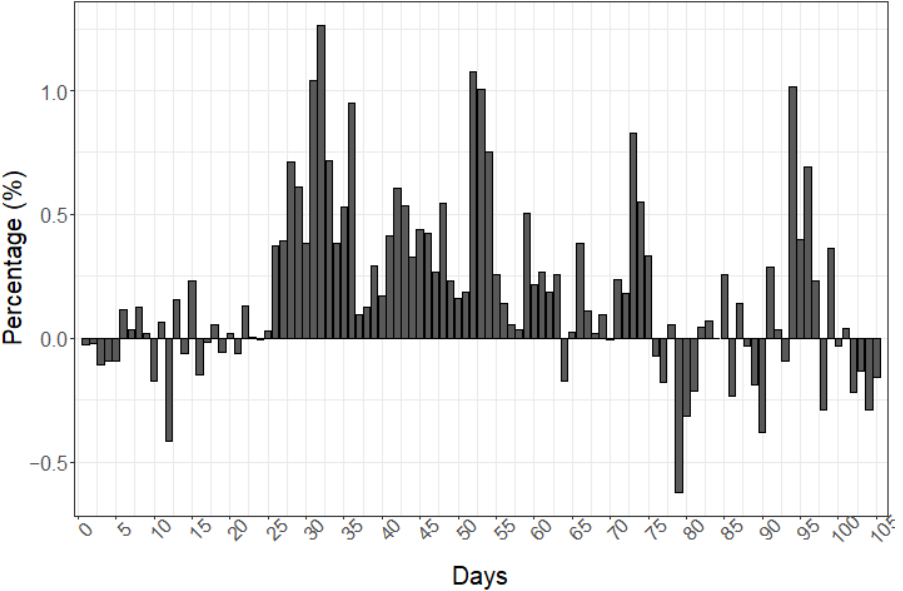
Figure 12. The percentage differences across the